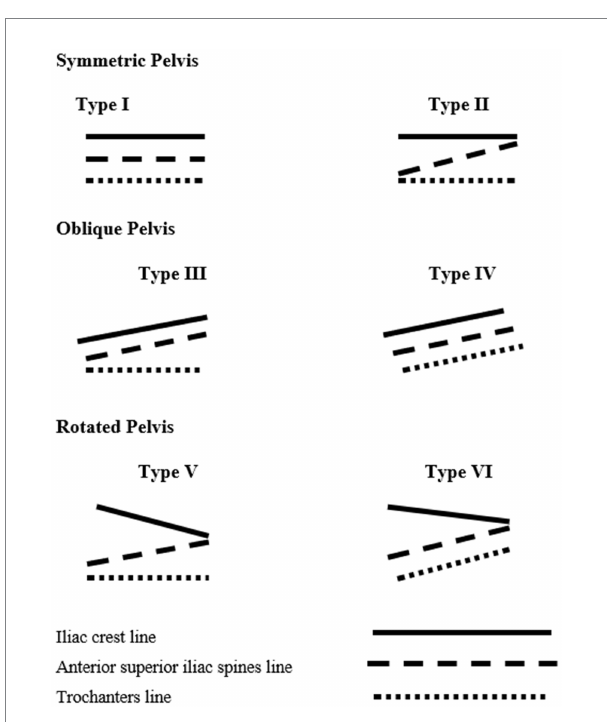
FIGURE 2 Graphic representation of pelvic asymmetry types (own